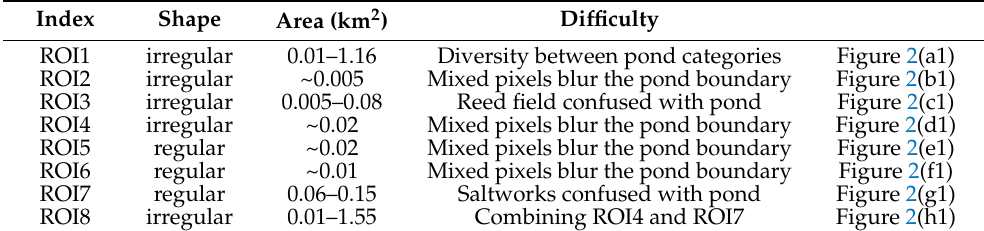
Figure 2. Morphological features and surrounding landscape of aquaculture ponds in eight test areas ( a – h ). The water objects produced in each area are displayed in ( a1 – h1 ), and each color represents an object. The water object is marked as T when accurately depicting the shape of the pond, otherwise, it is marked as F. The main error factors are marked in red letters below for the traditional shape parameter classification method. Table 2. Classification characteristics of each site and the difficulties in extraction.